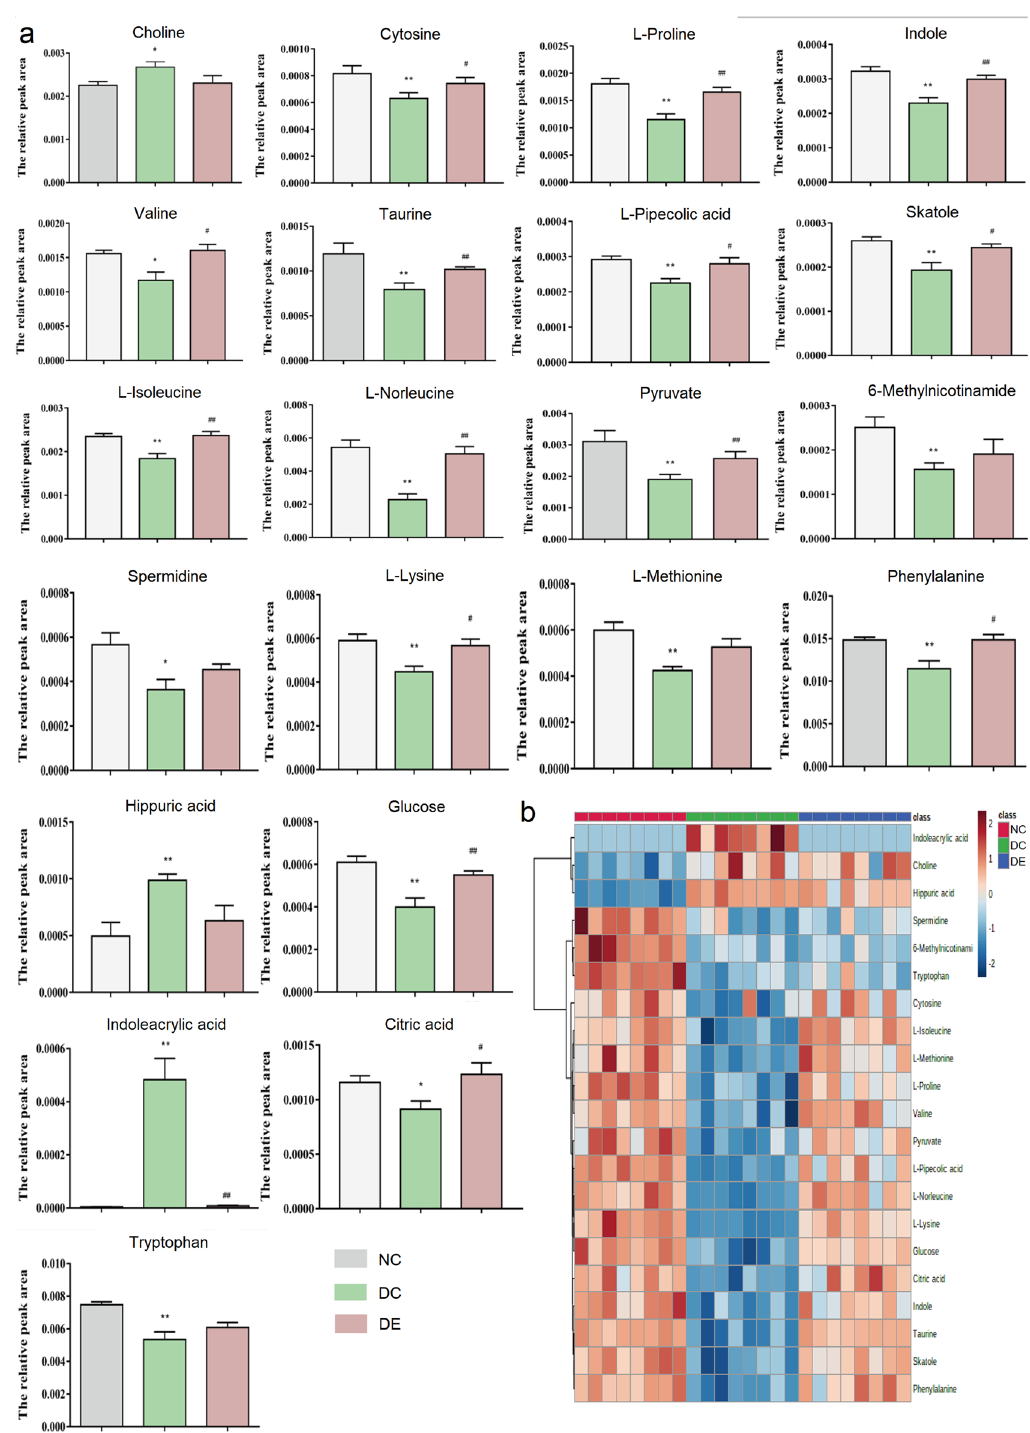
Figure 3. ( a ) Comparison of the relative peak areas of differential metabolites. All data were expressed as mean ± SD (n = 8). * p < 0.05, ** p < 0.01 versus NC; # p < 0.05, ## p < 0.01 versus DC. ( b ) The relative content of the heat map of differential metabolites in serum samples of rats under CUMS. CUMS chronic unpredictable mild